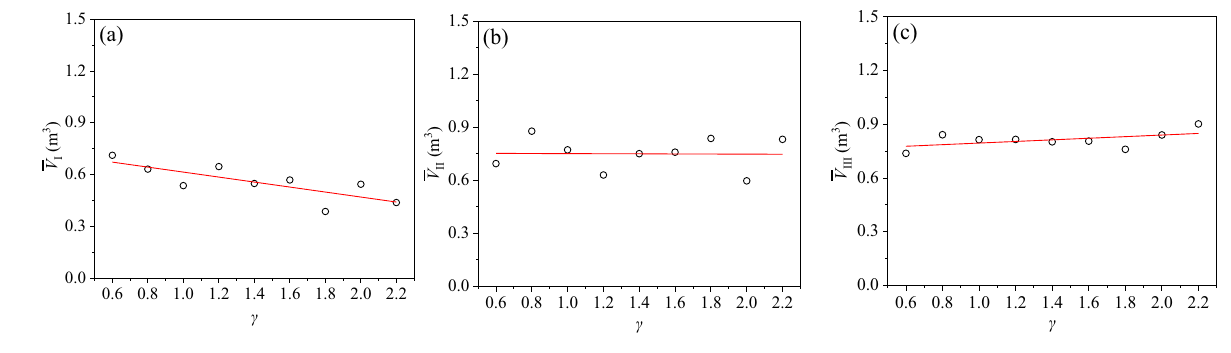
Fig. 11 Variation of the average volume of drawing bodies with γ : a S